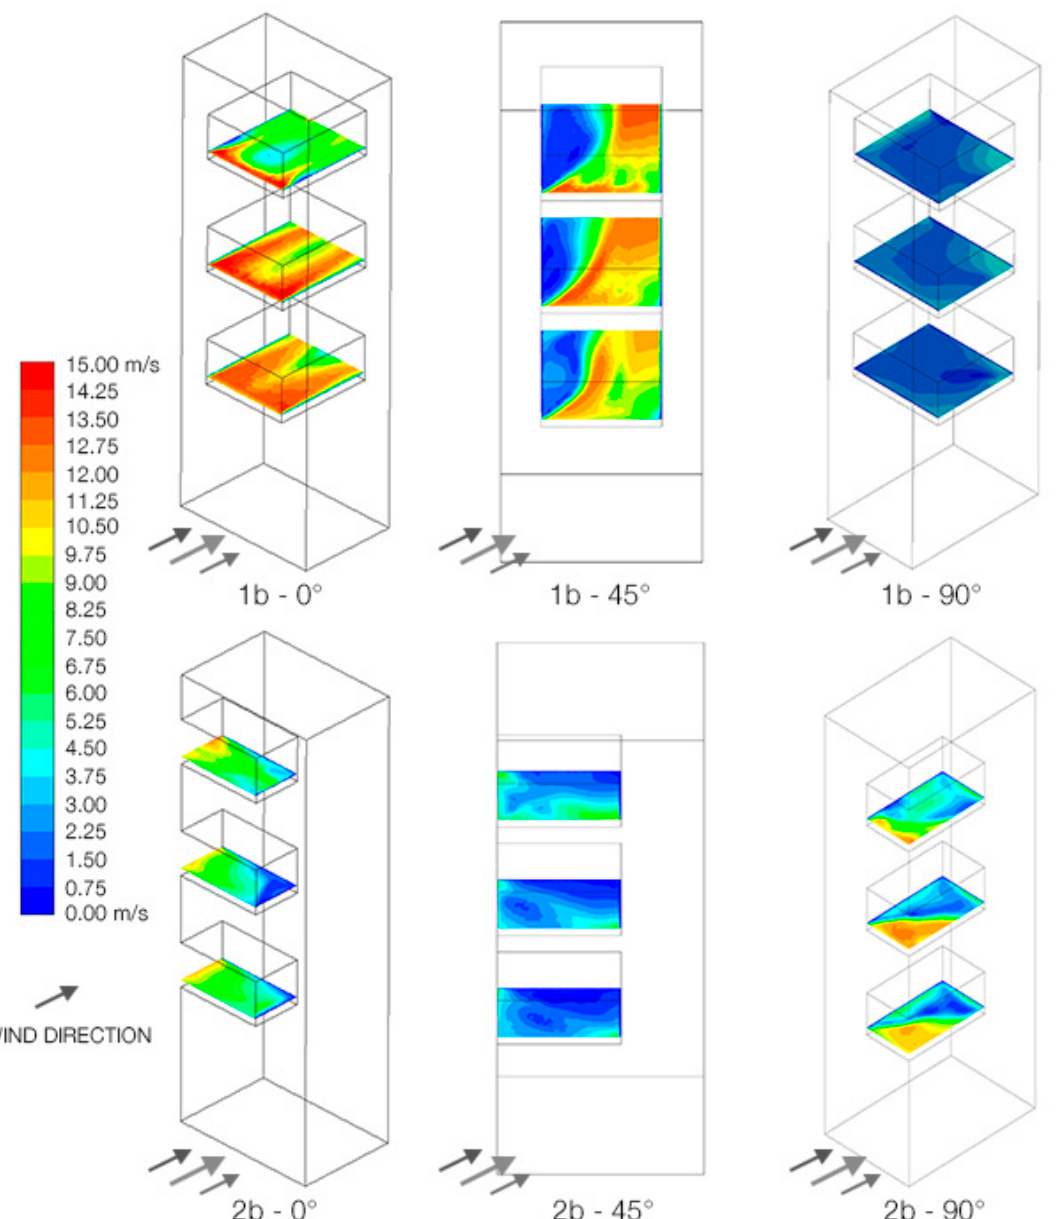
Figure 12. Velocity map in sky gardens when the wind is at an oblique angle to the building; (1b) Central sky garden b/B = 0.6 at 0 ◦ , 45 ◦ and 90 ◦ wind angle, (2b) Corner sky garden b/B = 0.6 at 0 ◦ , 45 ◦ and 90 ◦ wind angle.